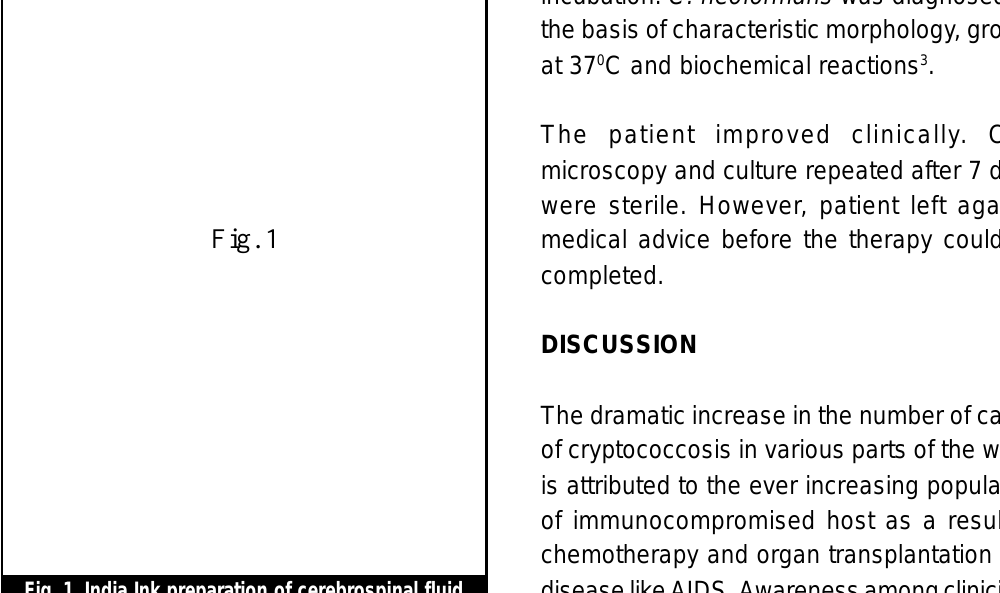
Fig. 1, India Ink preparation of cerebrospinal fluid showing capsulated and budding morphology of Crytococcus neoformans ( X